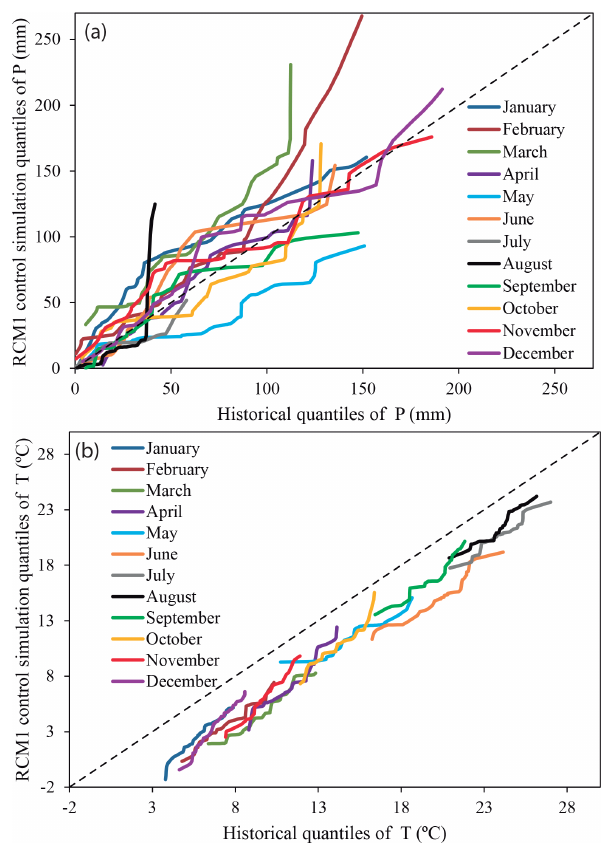
Figure 6. Precipitation (a) and temperature (b) quantiles of the ob- served and control series of the RCM1 simulations for each month of the year in the reference period (1972–2001). Table 3. Classification of corrected RCMs according to their reli- ability considering basic (mean, standard deviation and skew co- efficient) and drought statistics (frequency, length, magnitude and intensity) for the meteorological and hydrological analyses. Lower numbers represent a higher reliability. Statistics used in the classification (basic and drought)